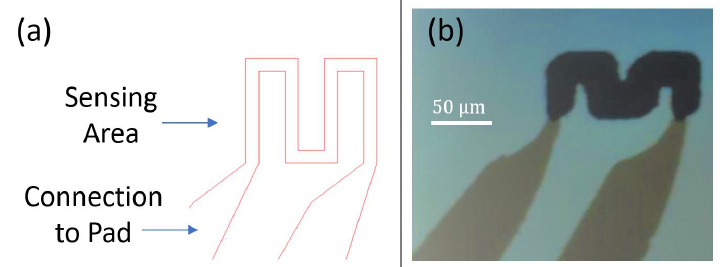
Figure 12. ( a ) Design revision 0.2 ( b ) Micro-fabricated